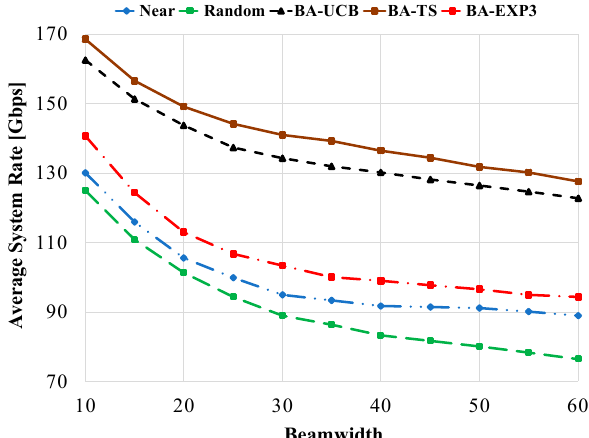
Figure 5. Average system rate against the number of gateway UAVs using access UAVs of 20 and a beam-width of 60°.